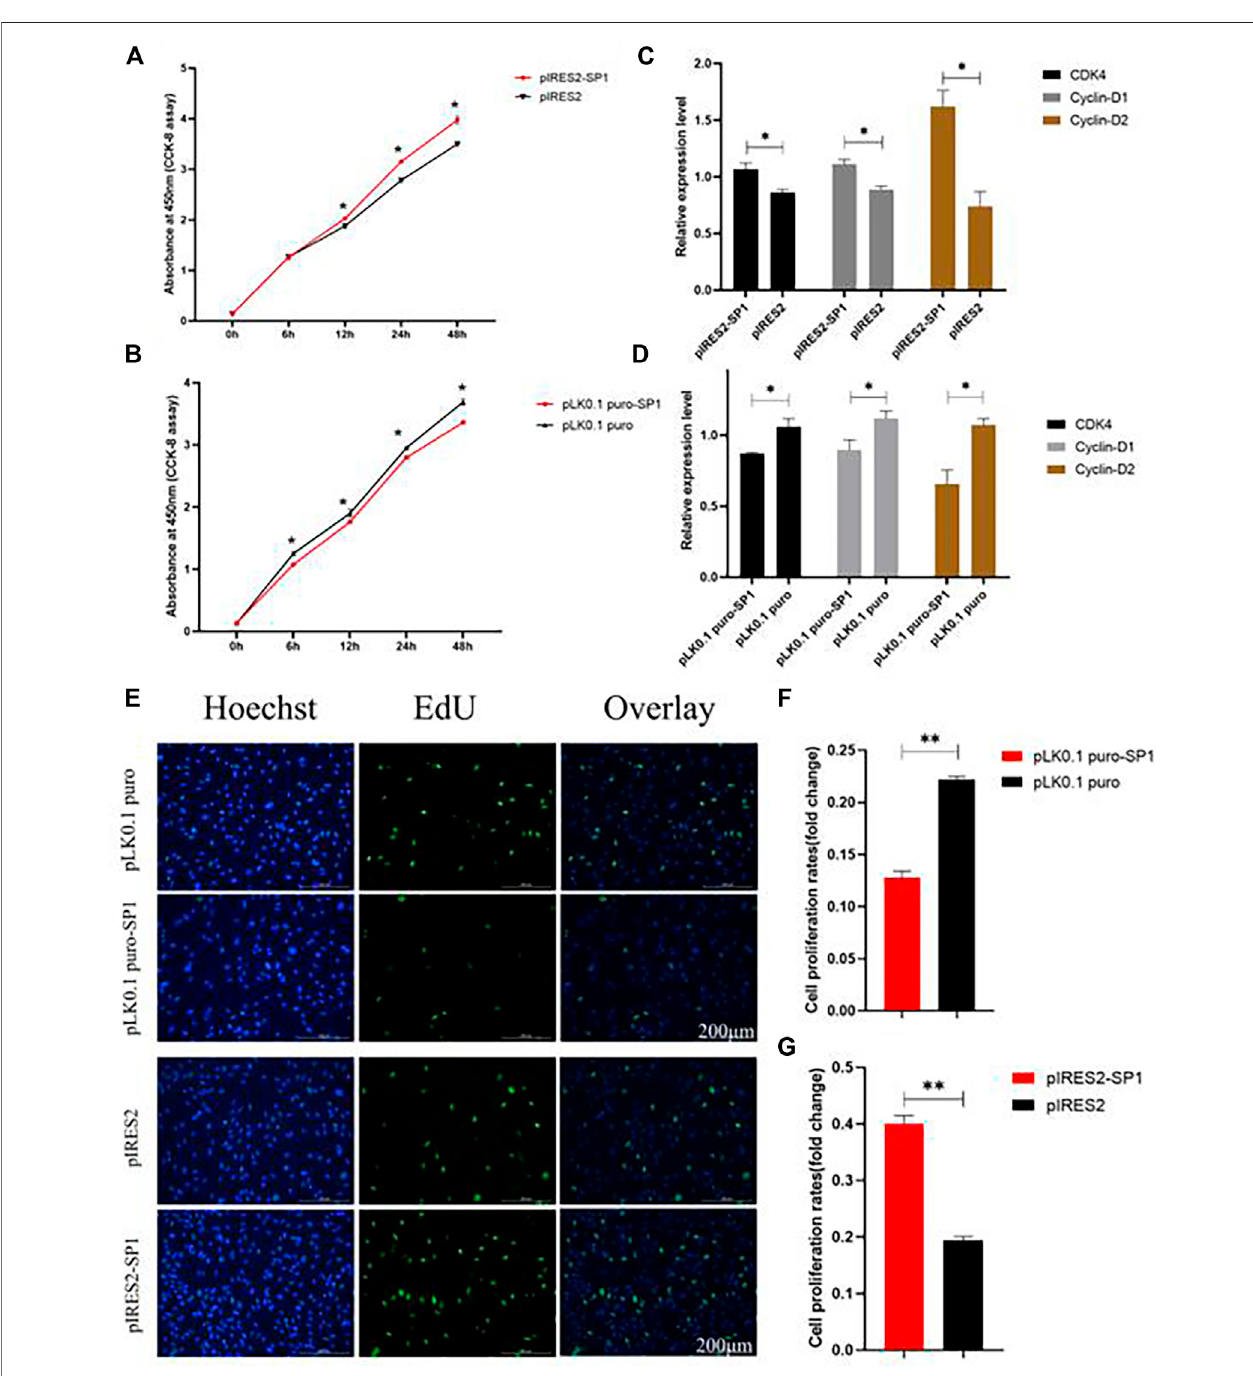
FIGURE 5 | Transcription factor SP1 regulates the proliferation of granulosa cells. (A) After SP1 was overexpressed, the cell counting kit-8 (CCK-8) was used to determine the proliferation curve of granulosa cells. (B) After interfering with SP1, Cell Counting Kit-8 (CCK-8) was used to determine the proliferation curve of granular cells. (C) Expression abundance of cell proliferation – related genes ( CDK4 , cyclinD1, and cyclinD2) was detected after overexpression of SP1 by RT-qPCR. (D) Expressionabundanceofcellproliferation – relatedgenes( CDK4 ,cyclinD1,andcyclinD2)wasdetectedafterinterferencewithSP1byRT-qPCR. (E) Granulosacells stained positive for 5-ethynyl-2-deoxyuridine (EdU) were detected with an EdU kit after SP1 overexpression and inhibition, EdU (red), Hoechst (blue). (F,G) Fold change of granulosa cell proliferation rate after SP1 overexpression and inhibition. Bars represent the mean ± SEM of at least three repeats. * p < 0.05; ** p < 0.01.